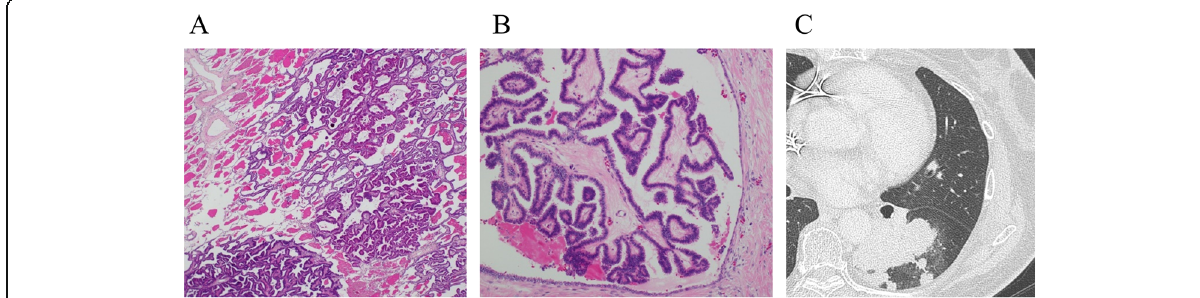
Fig. 5 Histopathological and computed tomography (CT) findings of lung adenocarcinoma that was resected 2 years before pancreatectomy. a Hematoxylin-eosin staining (× 40). This figure shows a part, including the boundary with the non-tumor part. Tumors formed papillary structures in some places, and there were also alveolar epithelial replacement growths. b Hematoxylin-eosin staining (× 200) showed the power field of a . c Lung cancer had been detected at the left lower lobe as a solid tumor by